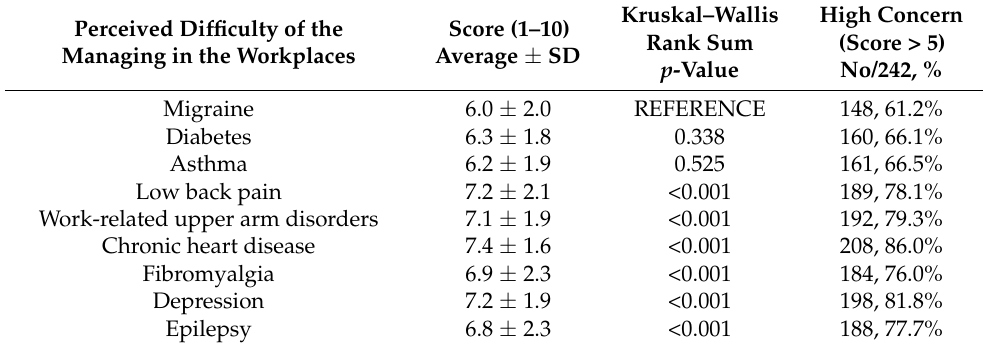
Table 4. Perceived difficulty in the managing of migraine in the workplaces as reported by participants through a synthetic score 1 (no concern) to 10 (very high concern), compared to a series of common disorders. Kruskal–Wallis rank sum test was performed in order to compare migraine (assumed as a reference category) to the other disorders. Perceived concern score was then dichotomized in low concern (i.e., 1 to 5) vs. high concern (6 to